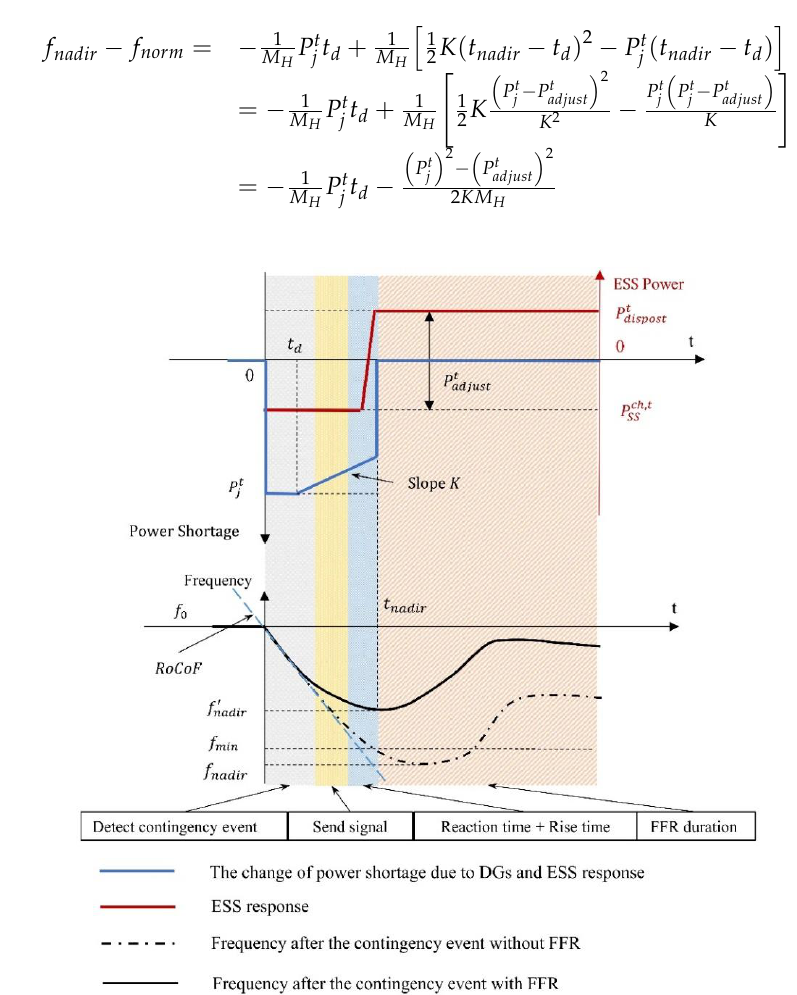
Figure 1. Application of an energy storage system for fast frequency response.